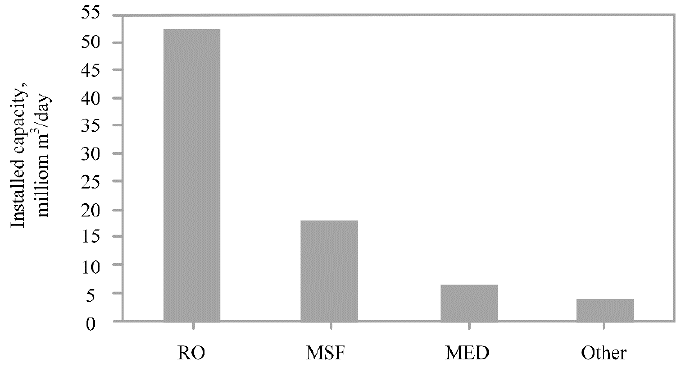
Fig. 2. Total desalination capacity installed worldwide by technology in 2013